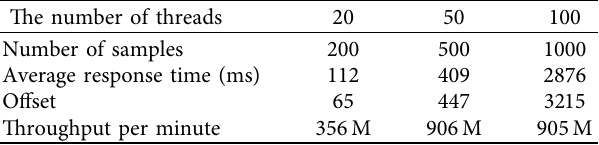
Table 5: Pressure test results.